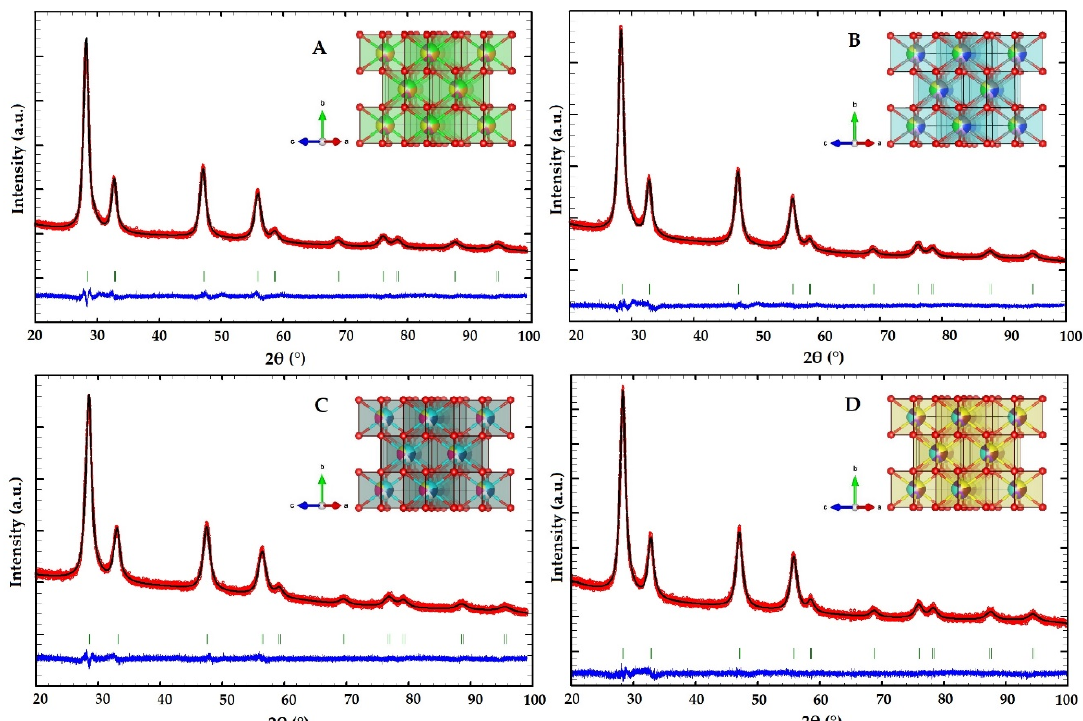
Figure 1. Rietveld plot of the investigated compounds: ( A ) CZLEY; ( B ) CZLPY; ( C ) CZEYG; ( D ) CZLPG. Along with Bragg reflections, the observed (red), calculated (black), and difference (blue) plots are shown for the fit of the PXRD pattern. In the insets of each figure, the fluorite-type crystal structure of the corresponding HEO is visualized.